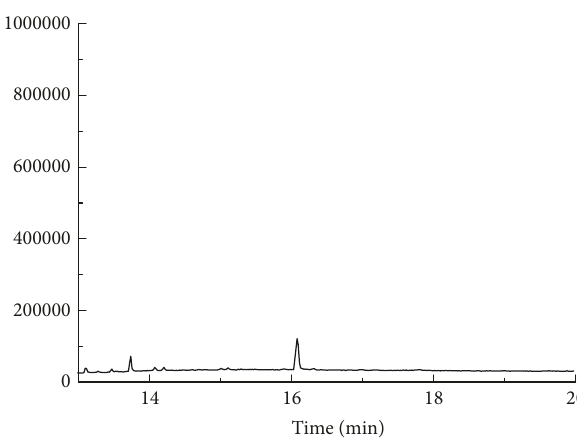
Figure 7: The chromatograms of the Maofeng